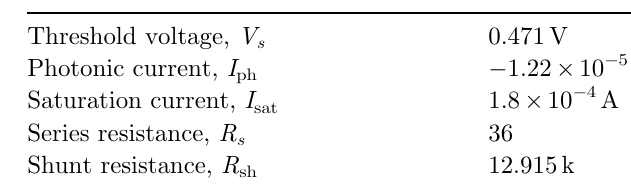
Table 2. Electrical parameters of the ZnO/Ge photo-